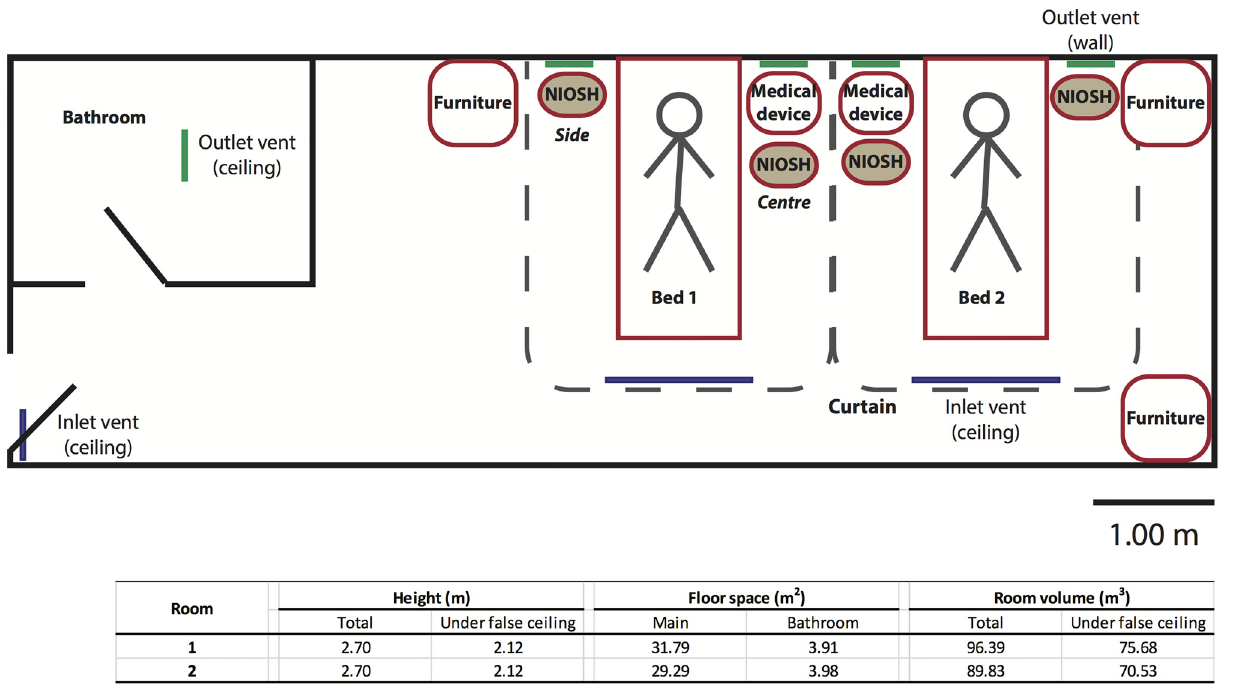
Fig 1. The layout of the patient rooms in which the air sampling for influenza A virus was conducted. The figure shows the usual positions for which the furniture, medical devices and the stationary air sampling device are located in one of the two patient rooms where the air sampling was conducted, although they are freely to be moved around (border in red). The other inpatient room is the mirror image of the first. For example if Bed 1 was the sampling bed, the air sampling device could be located at either ‘ Centre ’ or ‘ Side ’ as illustrated in the diagram. The dimensions of the two patient rooms where the air samplings were conducted were also provided. NIOSH: the air sampling device; Blue line: inlet vent; Green line: outlet